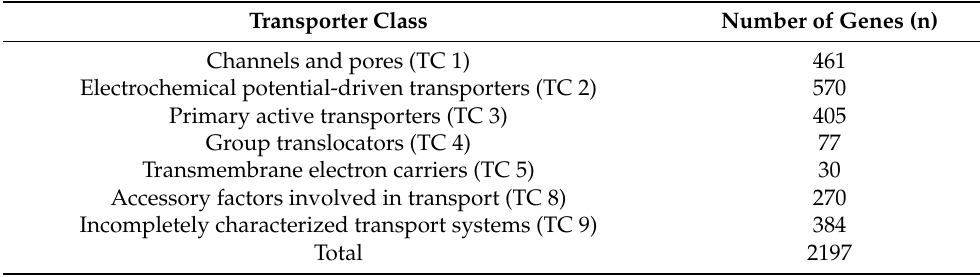
Table 3. Genes predicted to code for transporters in the genome of Emericellopsis cladophorae MUM